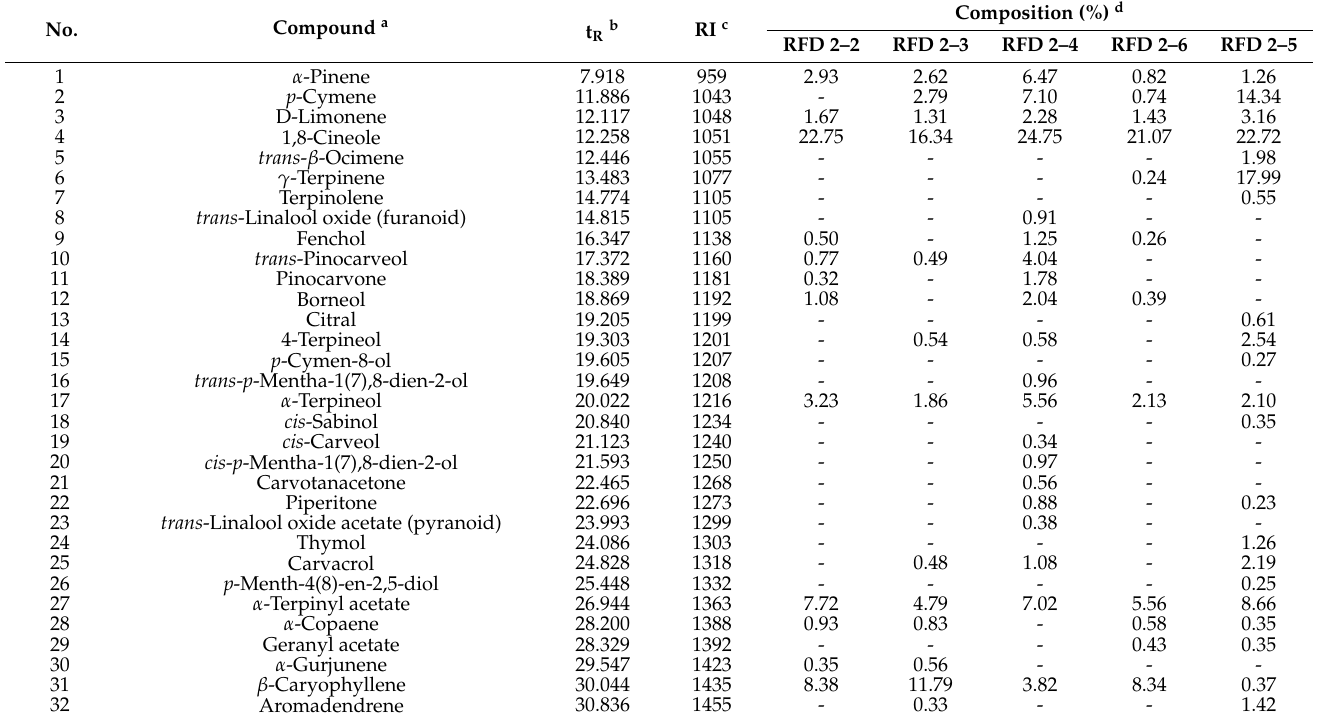
Table 1. Extraction yields and terpenoids compositions (%) of the five eucalypt oils from the leaves of E. urophylla clones (RFD 2–2, RFD 2–3, RFD 2–4, and RFD 2–6) and the E. urophylla × E. camaldulensis hybrid clone (RFD 2–5) by GC/MS.